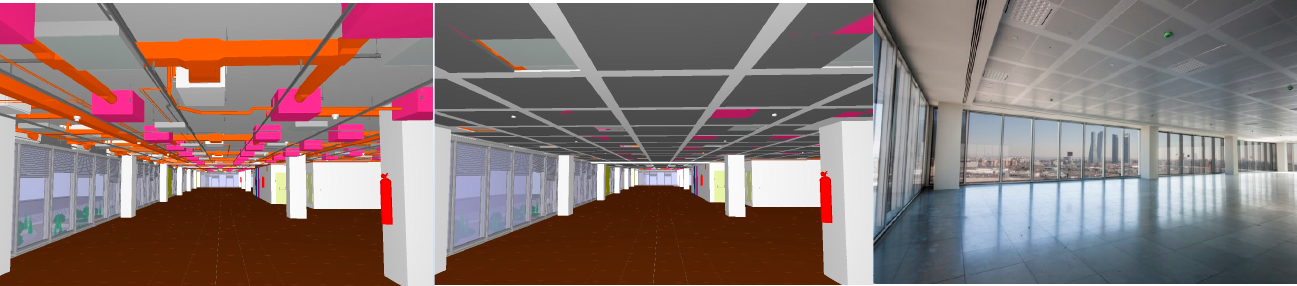
Figure 11. Representation of the BIM coordinated model of facilities ( left ), with architectural ele- ments ( center ), and the final image of the built real space ( right ).